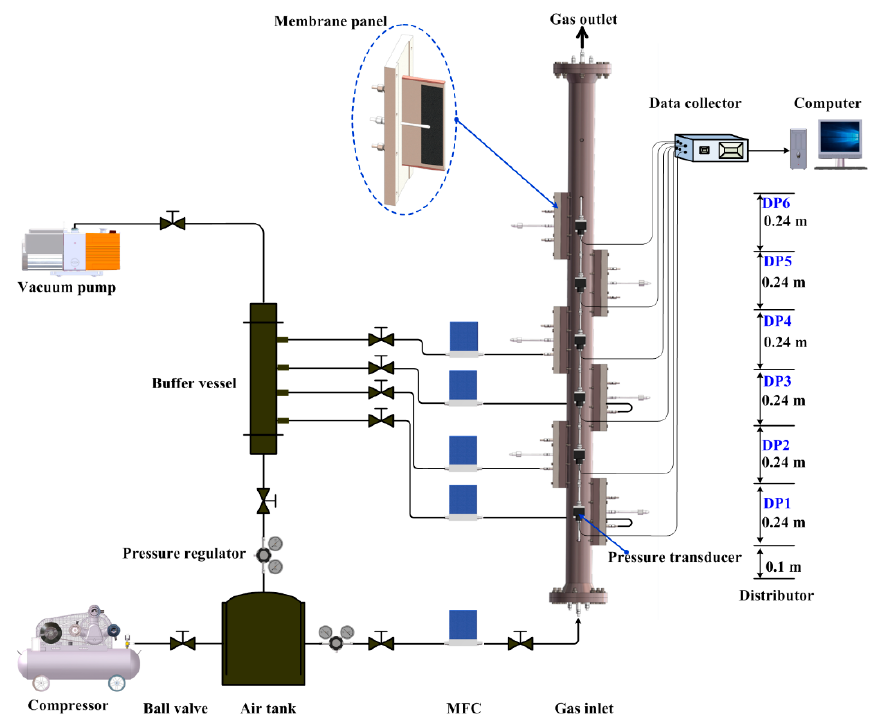
Figure 1. Scheme of the experimental system.